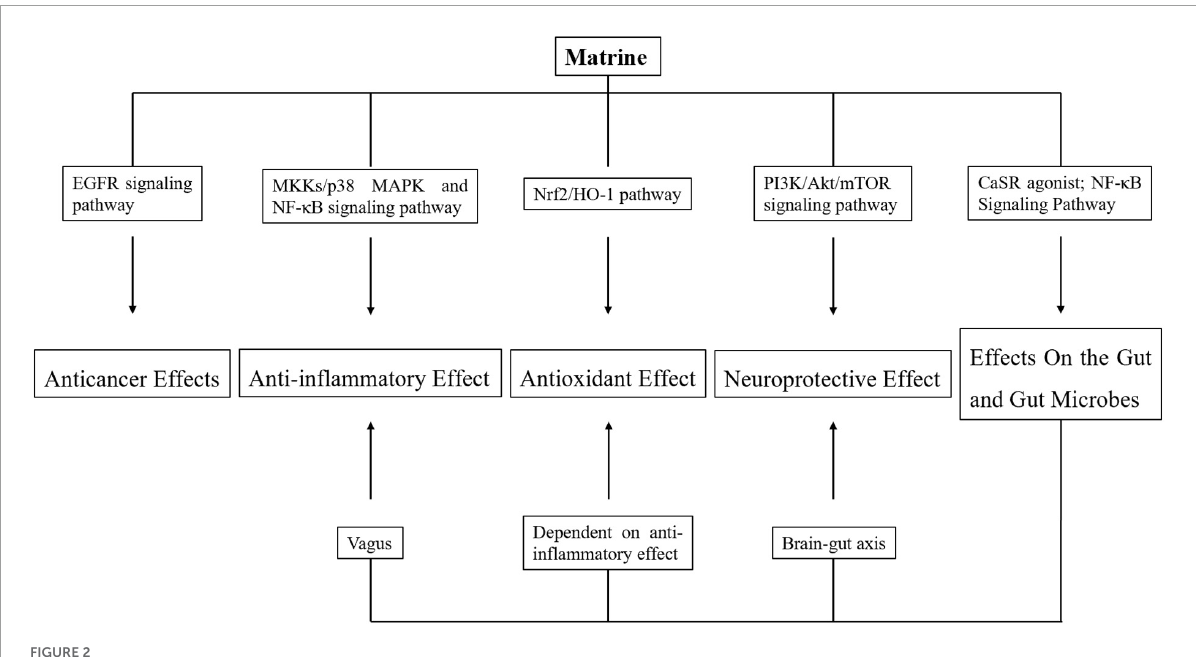
FIGURE2 Pharmacological activities of